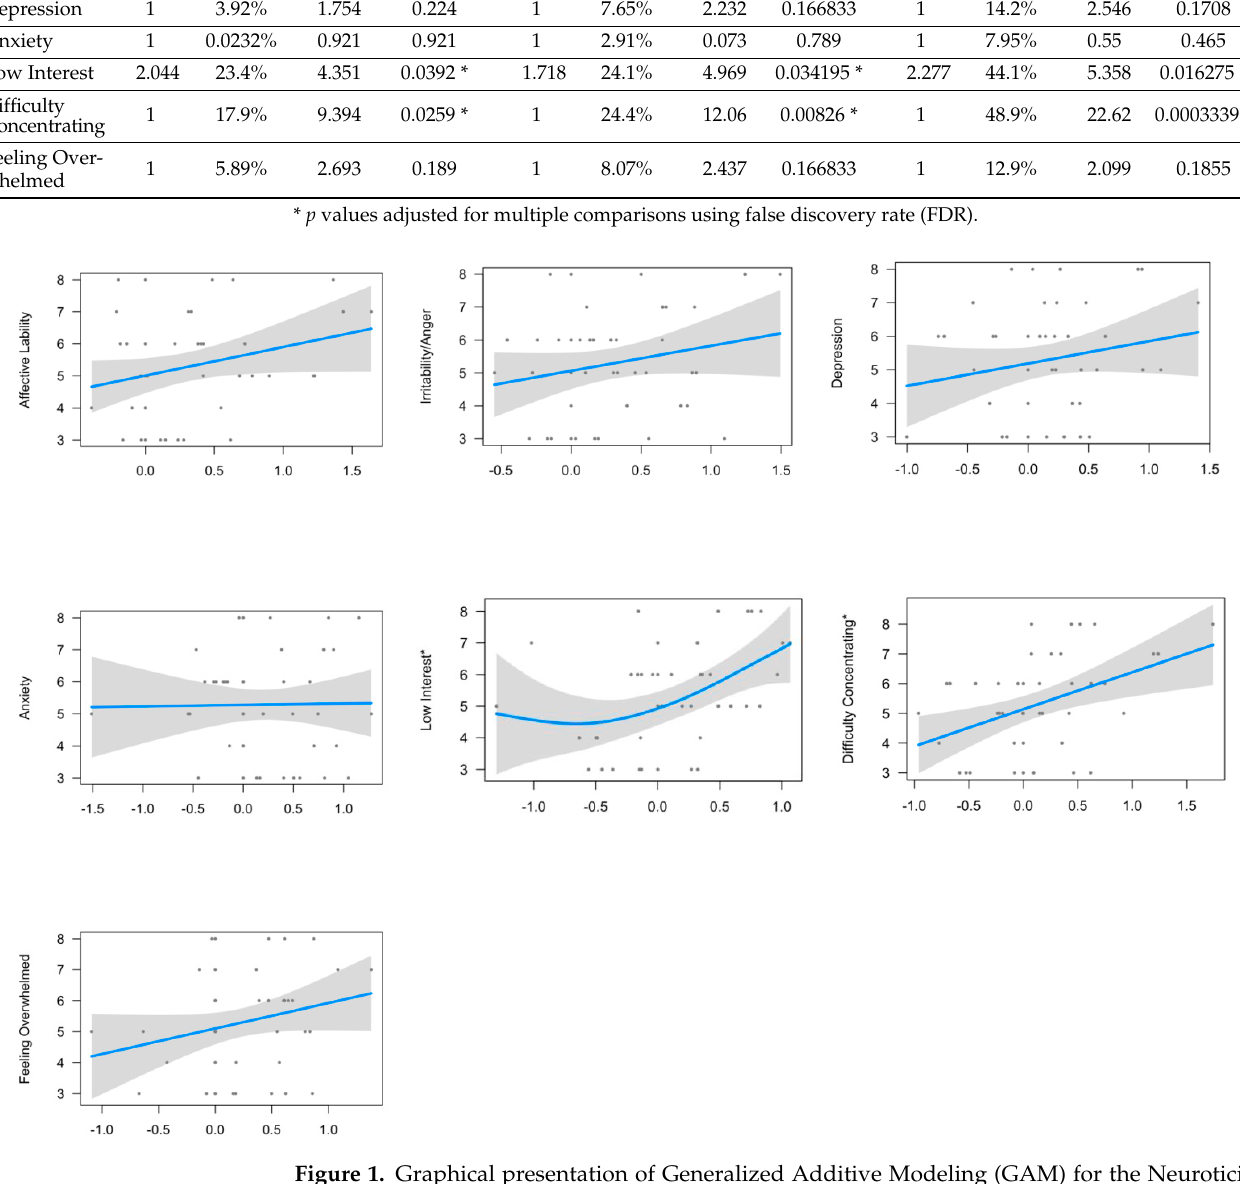
Figure 1. Graphical presentation of Generalized Additive Modeling (GAM) for the Neuroticism- Anxiety Personality Trait in Relation to Premenstrual Symptoms. Psychological symptoms “low interest” and “difficulty concentrating” were significantly associated with